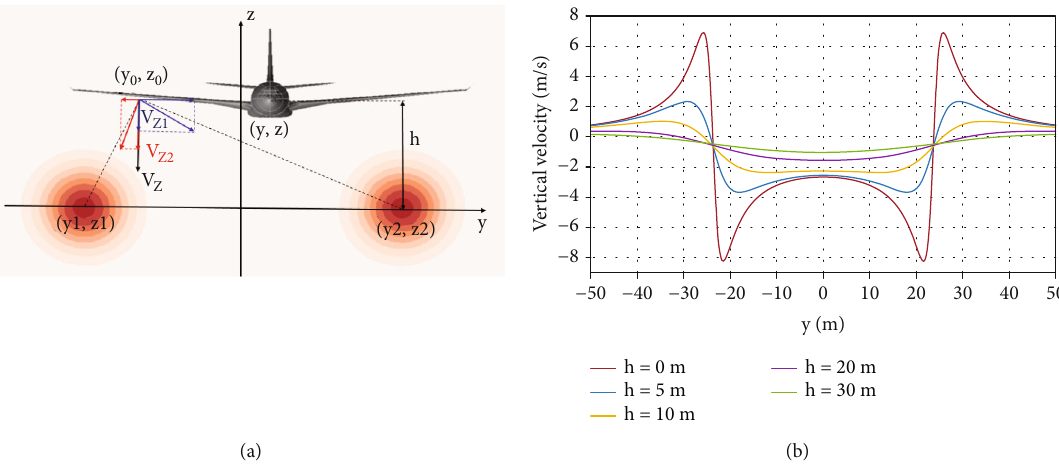
Figure 12: The force of the ARJ21 aircraft encountering the wake. (a) Two-dimensional plane coordinate system of the wake encountered by the following aircraft. (b) The vertical velocity distribution of the wake vortex of the B-H model in the spanwise